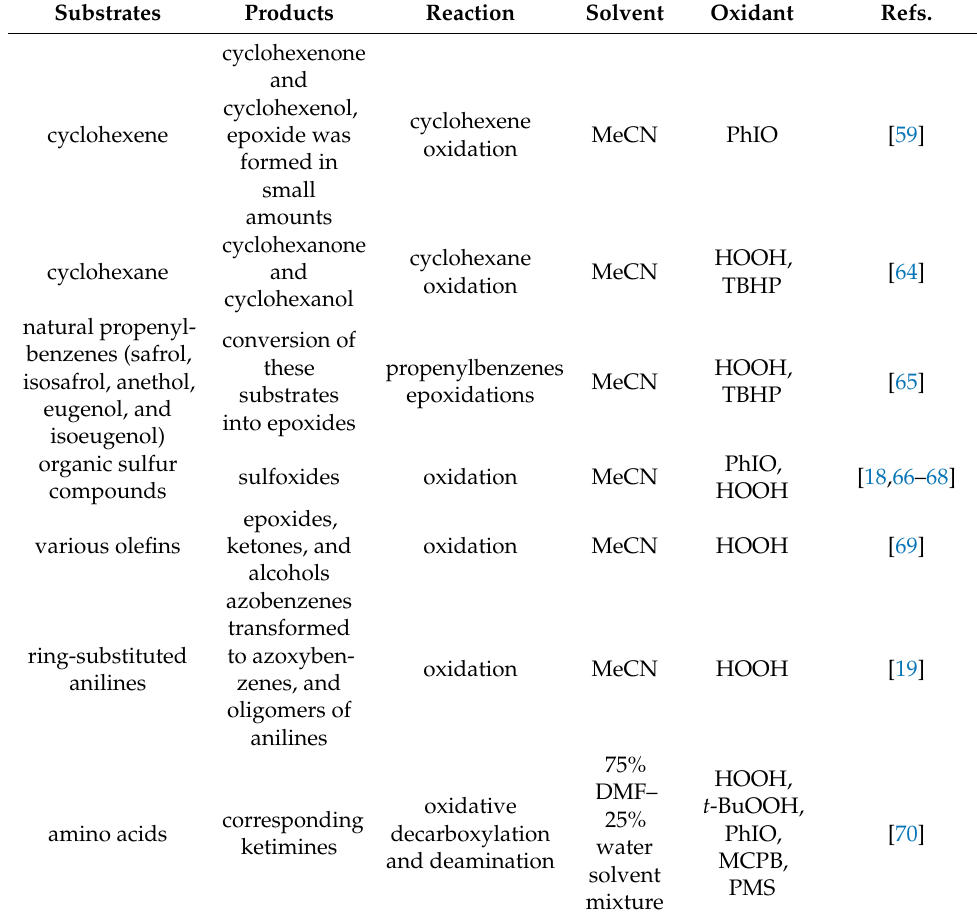
Table 1. Iron (III) salen complexes as catalysts for the oxidation of organic compounds. Substrates Products Reaction Solvent Oxidant Refs. cyclohexenone and cyclohexene